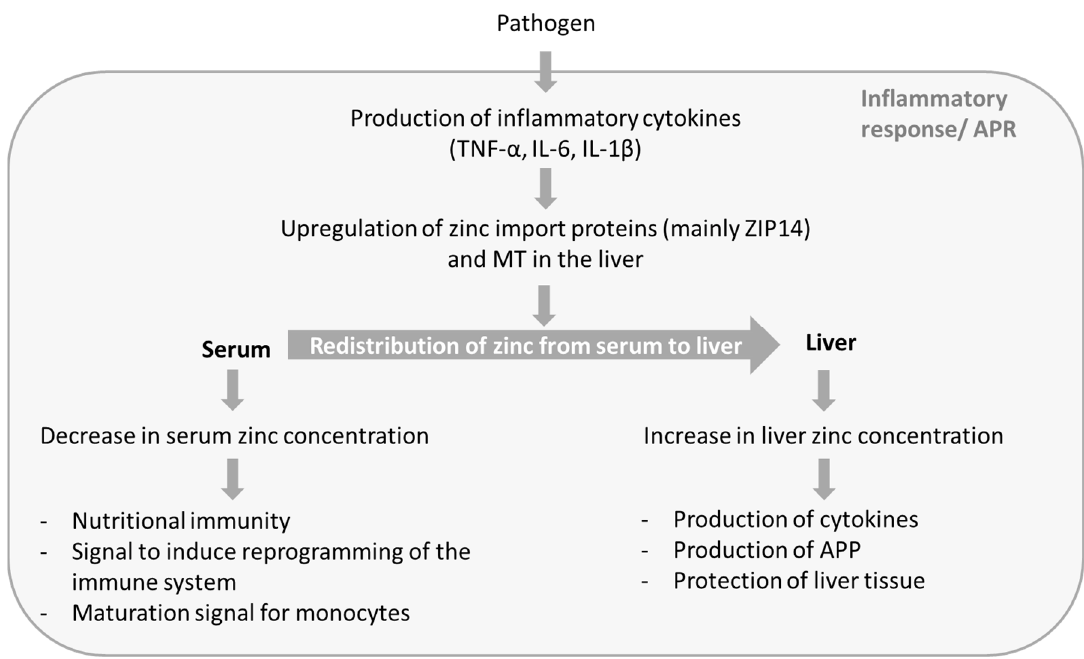
Figure 1. Possible functions of zinc in sepsis. During the APR of sepsis zinc is redistributed from serum to liver. This process results in decreased serum zinc concentration and increased liver zinc. The altered zinc concentrations seem to serve different functions and to be a part of the host’s defense against pathogens. APR: acute phase reaction; IL: interleukin; TNF: tumor necrosis factor; MT: metallothionein; APP: acute phase proteins.